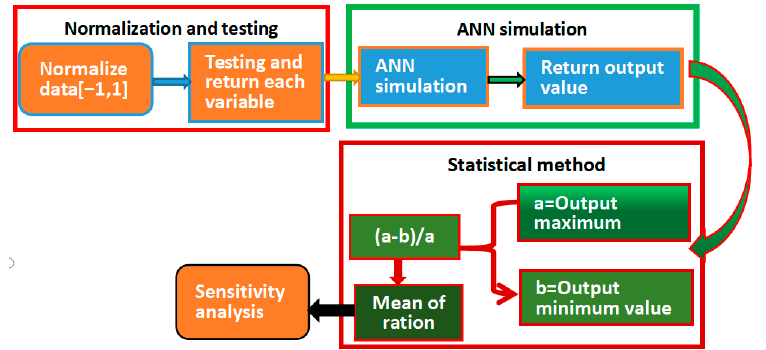
Figure 4. The sensitivity analysis flow.